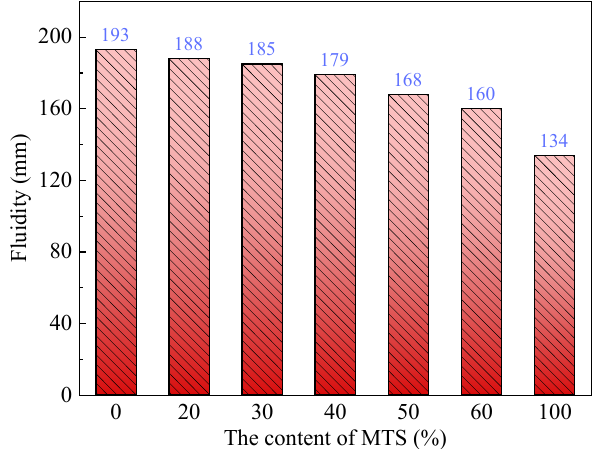
Figure 4. Effect of MTS content on fluidity of MTSC.